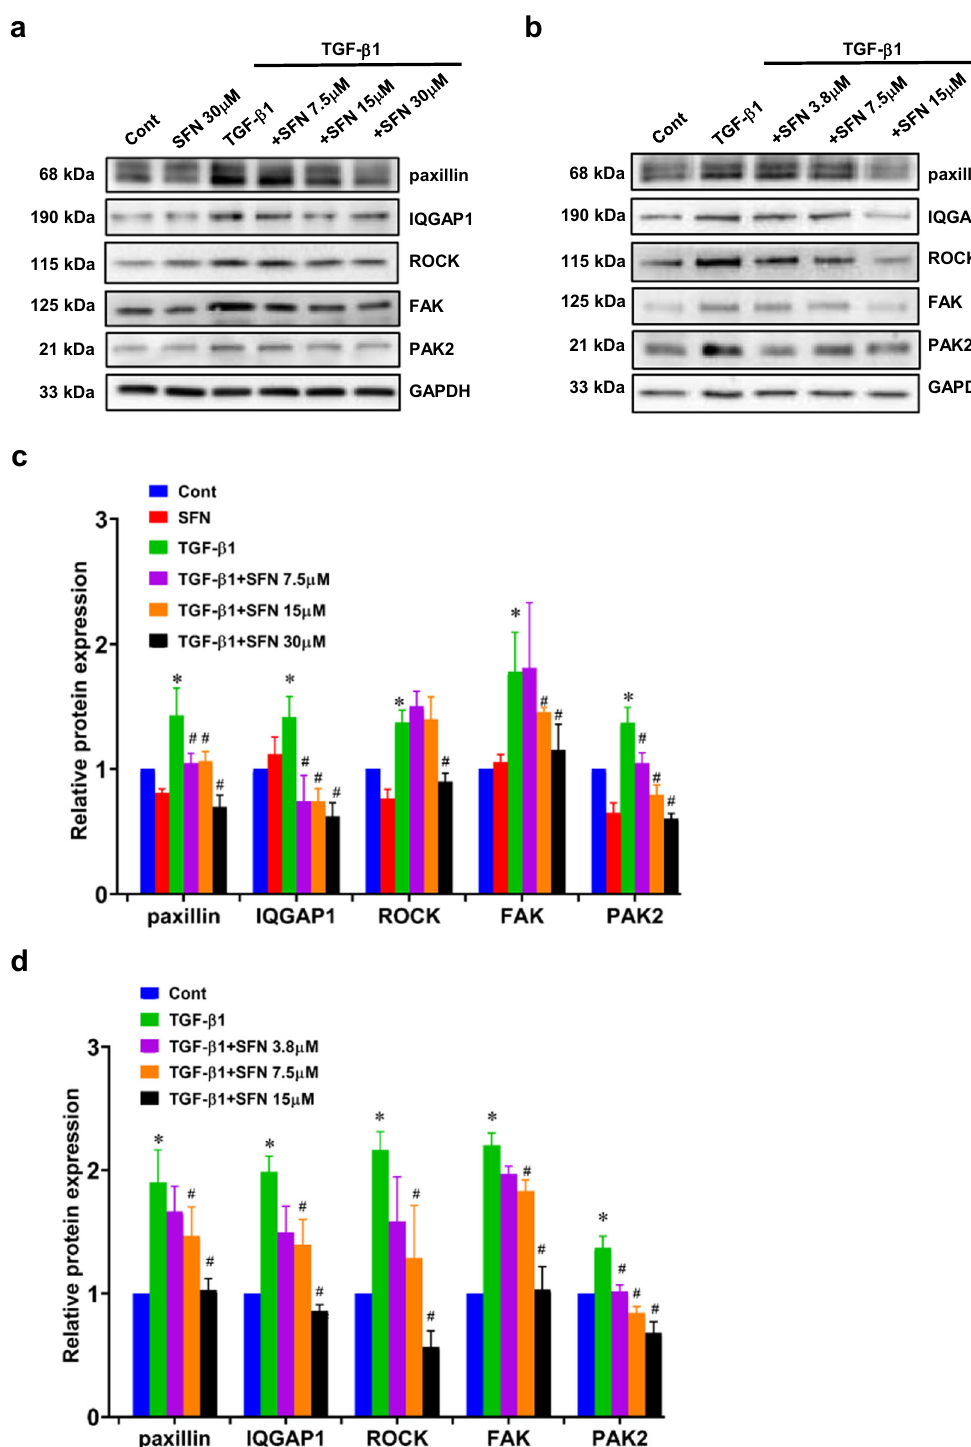
Fig. 7 SFN inhibits TGF- β 1-induced actin stress fi ber formation-associated protein expression. a , b Representative western blot results showing that the effects of SFN at different concentrations (7.5, 15, and 30 μ M for MDA-MB-231 cells and 3.8, 7.5, and 15 μ M for MDA-MB-157 cells) on TGF- β 1-induced actin stress fi ber formation-associated protein expression, including paxillin, focal adhesion kinase (FAK), Ras GTPase- activating-like protein (IQGAP1), Rho-kinase (ROCK), and p21-activated kinase 2 (PAK2) in MDA-MB-231 ( a ) and MDA-MB-157 ( b ) cells. c , d Statistical assay showing that the effects of SFN at different concentrations on TGF- β 1-induced actin stress fi ber formation-associated proteins expression in MDA-MB-231 ( c ) and MDA-MB-157 ( d ) cells. Data shown are mean ± SEM. n = 3, ∗ P < 0.05 vs Cont; # P < 0.01 vs TGF- β